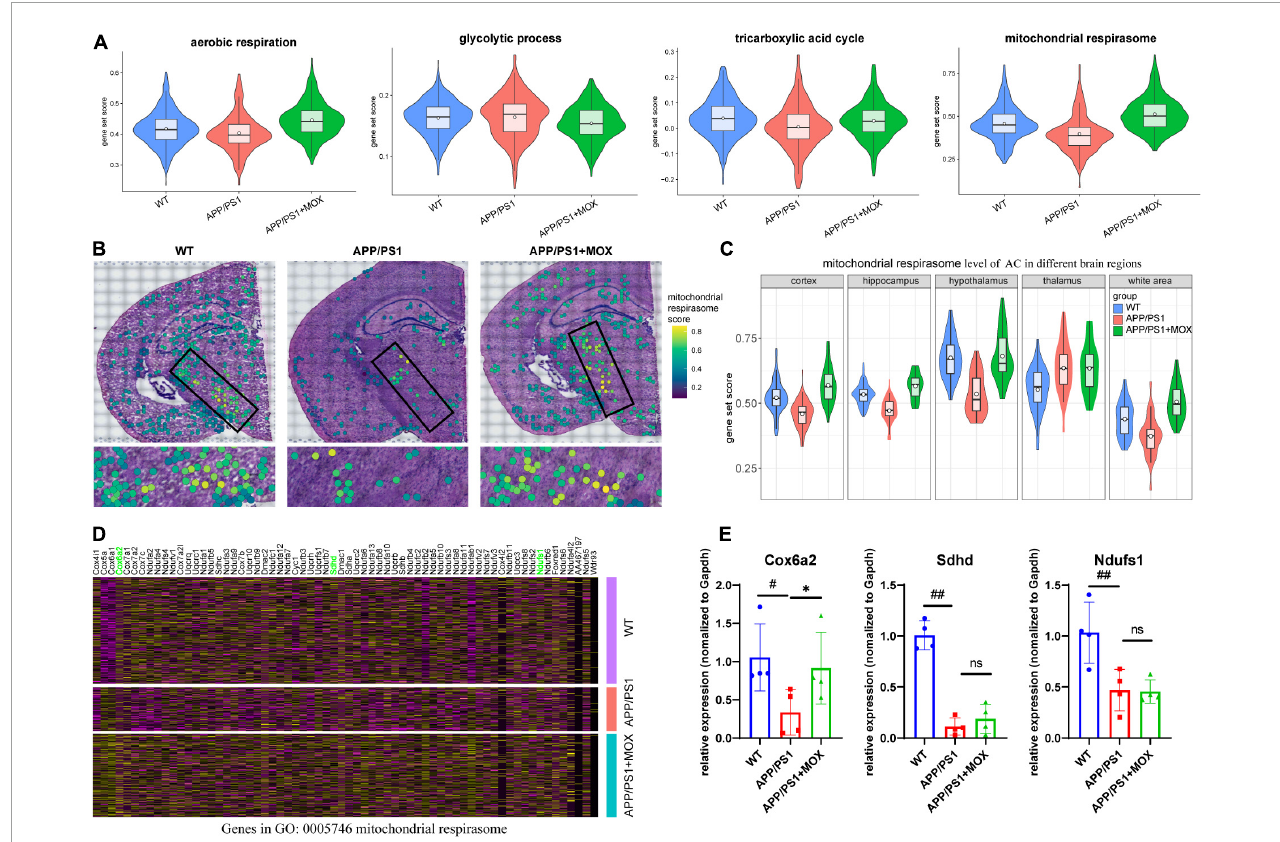
FIGURE6 The change in the mitochondrial respirasome level in perivascular astrocytes. (A) Violin plots of energy-related gene set score. The most significant change was observed in the mitochondrial respirasome. (B) Brain maps of mitochondrial respirasome levels. (C) Violin plots of mitochondrial respirasome levels in different brain regions. (D) A heatmap showing the DEG expressions, which were enriched for the pathway of mitochondrial respirasome (GO:0005746). (E) RT-qPCR analysis of mitochondrial respiratory chain enzyme mRNA Cox6a2 , Sdhd , and Ndufs1 ( N = 4). One-way analysis of variance with post-test # P < 0.05, ## P < 0.01, APP/PS1 vs. WT; ∗ P < 0.05, APP/PS1 + MOX vs.